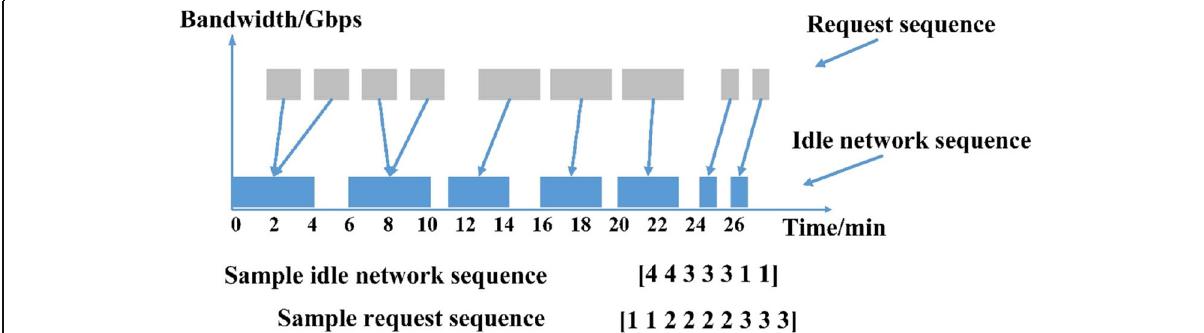
Fig. 1 SDN network data request model. As shown in Fig. 1, the optimization goal of SDN network data request model is to place the request into an idle network, making the total length of request that have been put into the idle network always the longest. The coupling relationship between requests depends on the specific coupling relationship. The network status can be simplified as ( T 1 , T 2 , … , T m ), where T i is the idle duration of the i th segment. In fact, you can add an extra idle duration of the ( m + 1 )th segment T m+1 , but we can omit T m+1 due to the last idle time T m+1 is infinitely long, considering putting the request in the idle network as front as possible in the sequence. The set of network requests is reduced to ( t 1 , t 2 , … , t n ) and t i is the time occupied by the i th request. In Fig. 1, the total length of idle network for the first group of networks is 19 and the total length of the request is 19, so the requests are all placed in the idle network. However, the idle network cannot all be filled in other situations that will be discussed